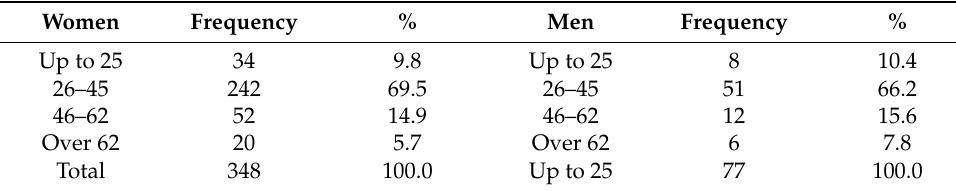
Table 1. Basic demographic information—age and